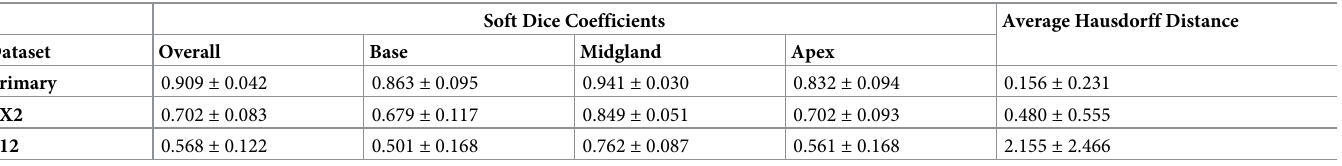
Table 1. Evaluation results for baseline models.